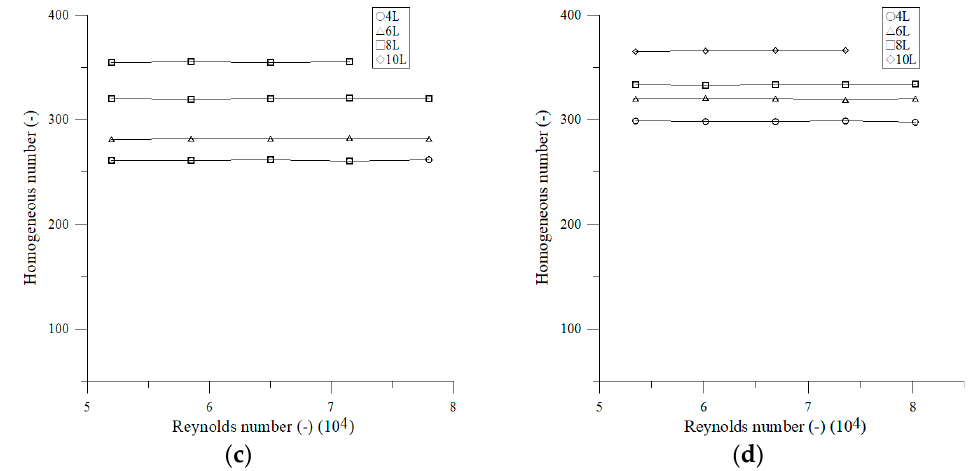
Figure 8. Effect of Reynolds number on mixing number. ( a ) Water; ( b ) 5 vol% glycerin; ( c ) 10 vol% glycerin; ( d ) 20 vol% glycerin.